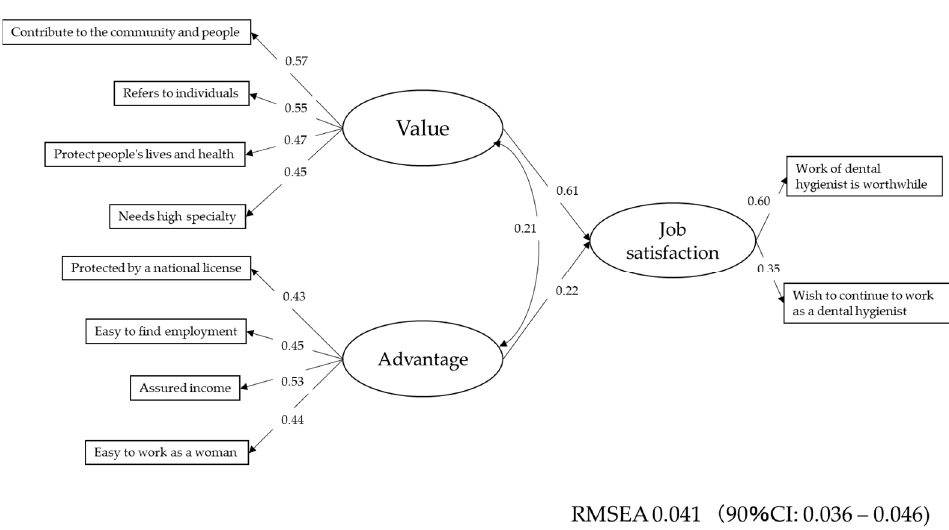
Figure 2. The path diagram of job satisfaction of dental hygienists. A path from “Value” to “Job satisfaction” was higher than that from “Advantage” to “Job satisfaction.” REMSEA stands for root mean square error of approximation.